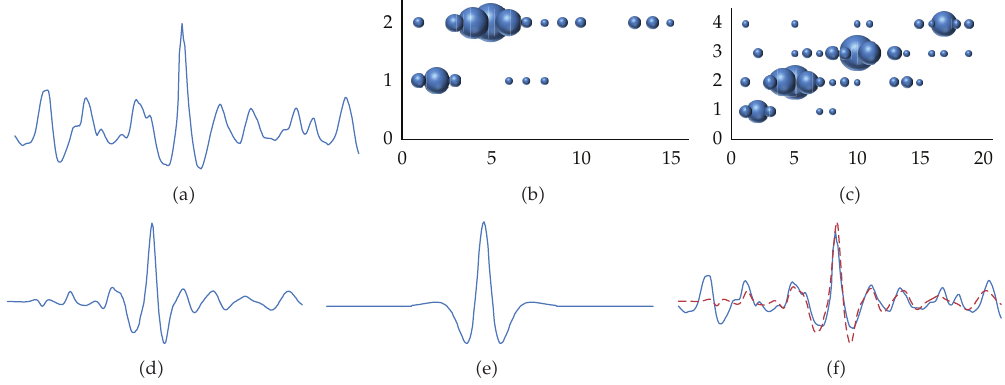
Figure 8: (cid:2) a (cid:3) Tsunami 46411 from DART, March 2011; (cid:2) b (cid:3) relative magnitude of coe ffi cients for 3 scales { q − 1 , 1 ,q } for q (cid:5) 1 . 5; (cid:2) c (cid:3) relative magnitude of coe ffi cients for 5 scales { q j } 3 approximation with 20 largest coe ffi cients; (cid:2) e (cid:3) largest magnitude of K q (cid:2) q (cid:5) 1 . 5, scale (cid:5) q 0 (cid:5) 1, shift (cid:5) 2 · b (cid:5) 3.9 (cid:3) ; (cid:2) f (cid:3) comparison between DART data and K q wavelet reconstruction.